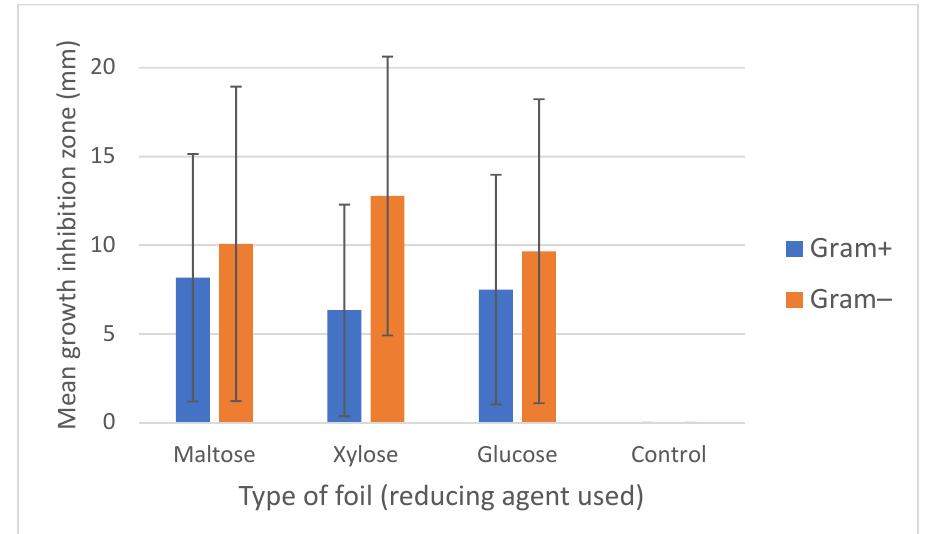
Figure 6. Mean growth inhibition zones (mm) caused by the three types of AgNP-containing foils produced using different reducing agents (maltose, xylose and glucose). The results are means of three replicates of tests conducted for all examined bacterial isolates ( n = 79). Bars represent standard deviation. Control foils (sole alginate) caused no growth inhibition.